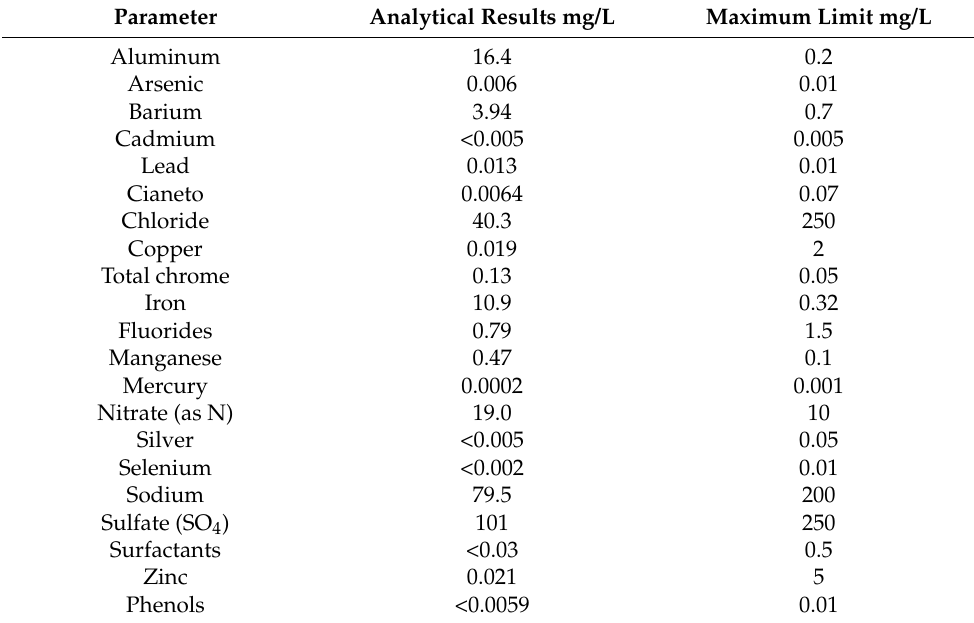
Table 8. Analysis of WFES solubilized extract.